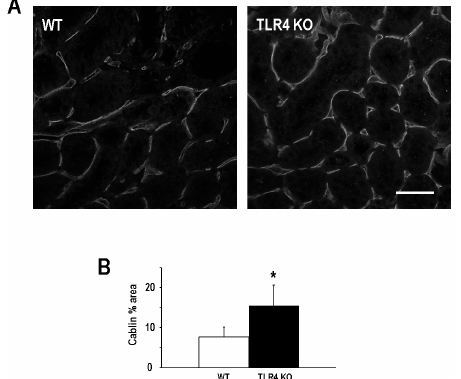
Figure 3. Deletion of TLR4 preserved microvascular density following an episode of ischemic AKI . Panel ( A ) demonstrates representative images of cablin immunostaining for WT and TLR4-deletion (TLR4 KO) mice at six weeks following a 19-min bilateral renal artery clamp; Panel ( B ) shows quantitation of cablin immunostaining (percent total area staining positive for cablin/field ±SD; 5–7 fields/animal; n = 4; * p < 0.05). Scale bar = 50 µm.